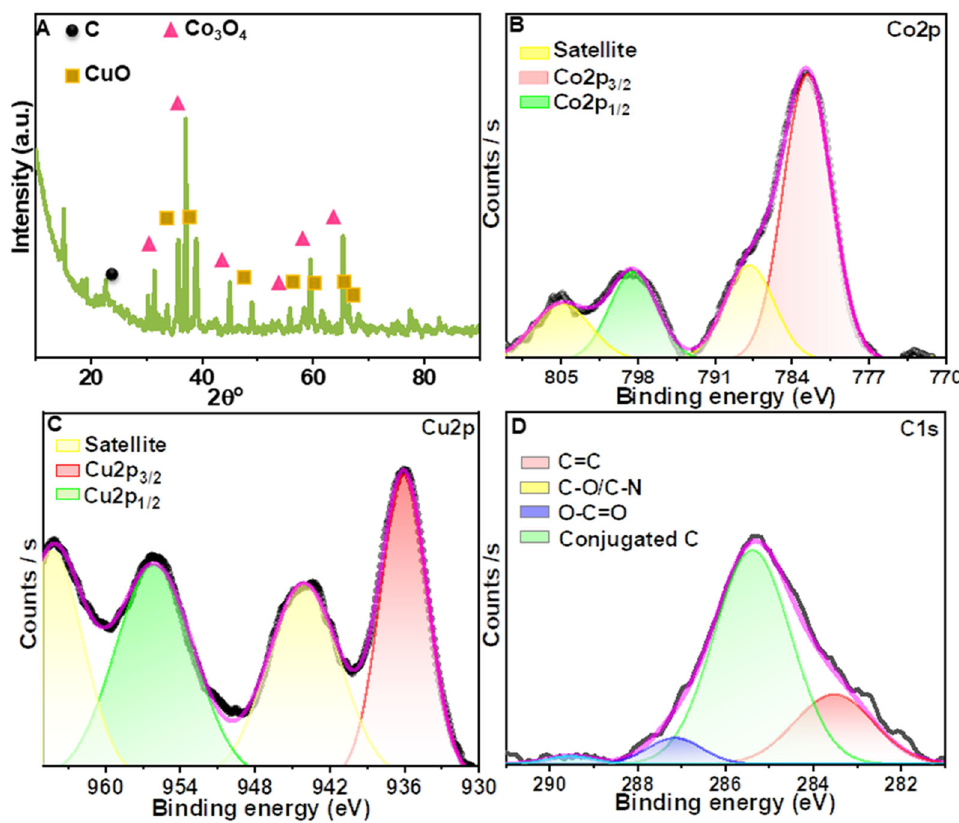
Figure 3. ( A ) The observed XRD pattern of CCuU. Narrow range XPS spectra of ( B ) Co2p, ( C ) Cu2p, and ( D ) C1s.